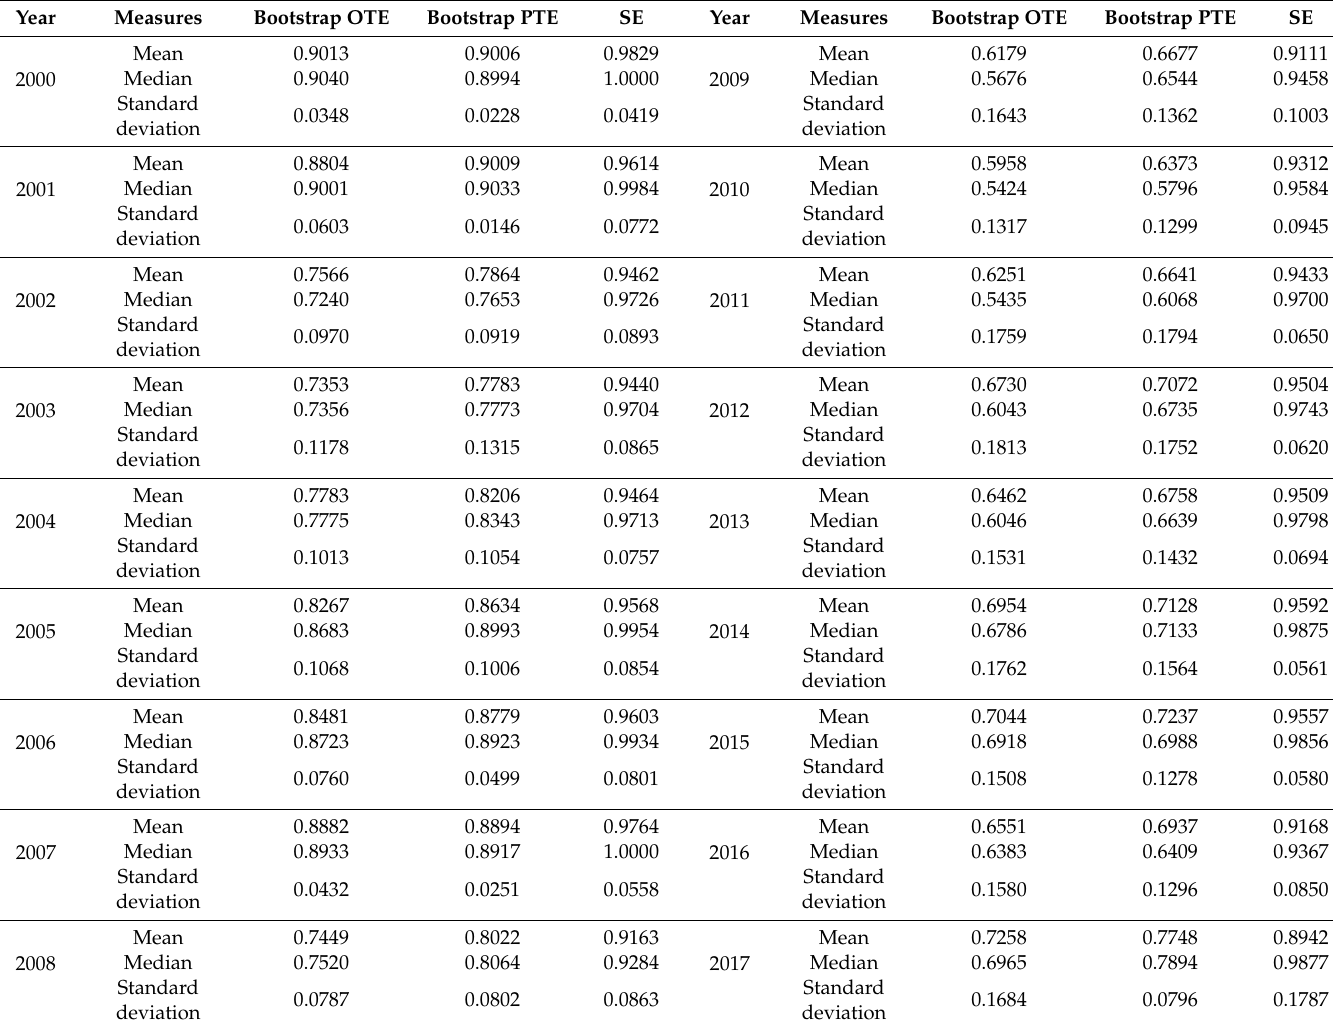
Table 4. Annual bootstrap OTE, bootstrap PTE, and the SE for the third